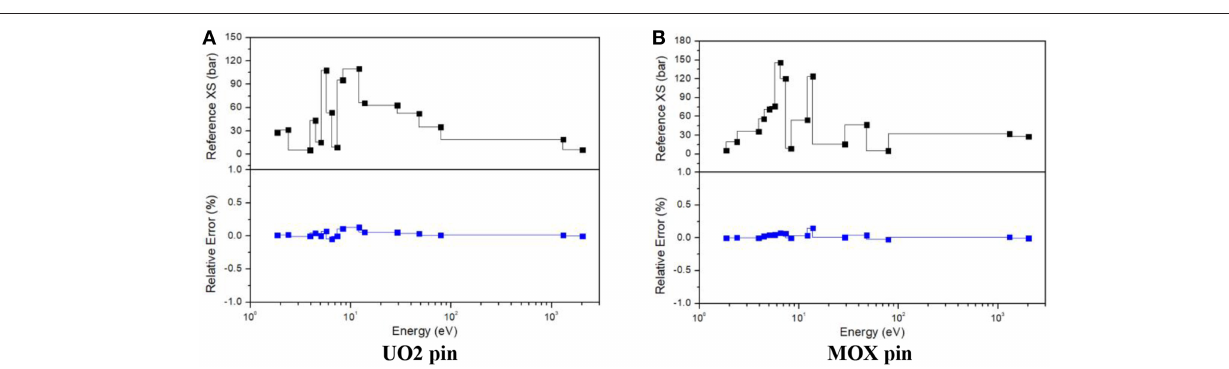
Frontiers in Energy Research |